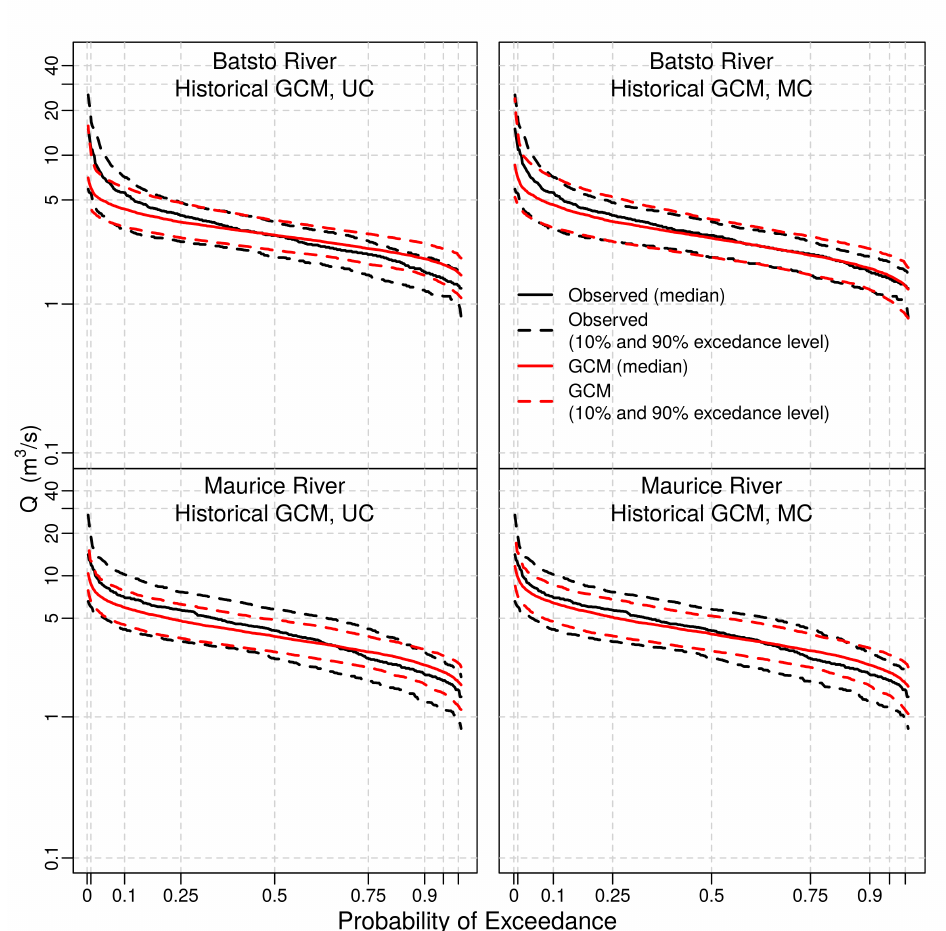
Figure 9. Annual flow duration curves for stream flow simulated for the Batsto River using downscaled climate projections for each GCM simulation (uncorrected (UC), and model corrected (MC)) used in the analysis. The observed FDC is the thick black line, and the thick blue line is the FDC for the simulated data using the full